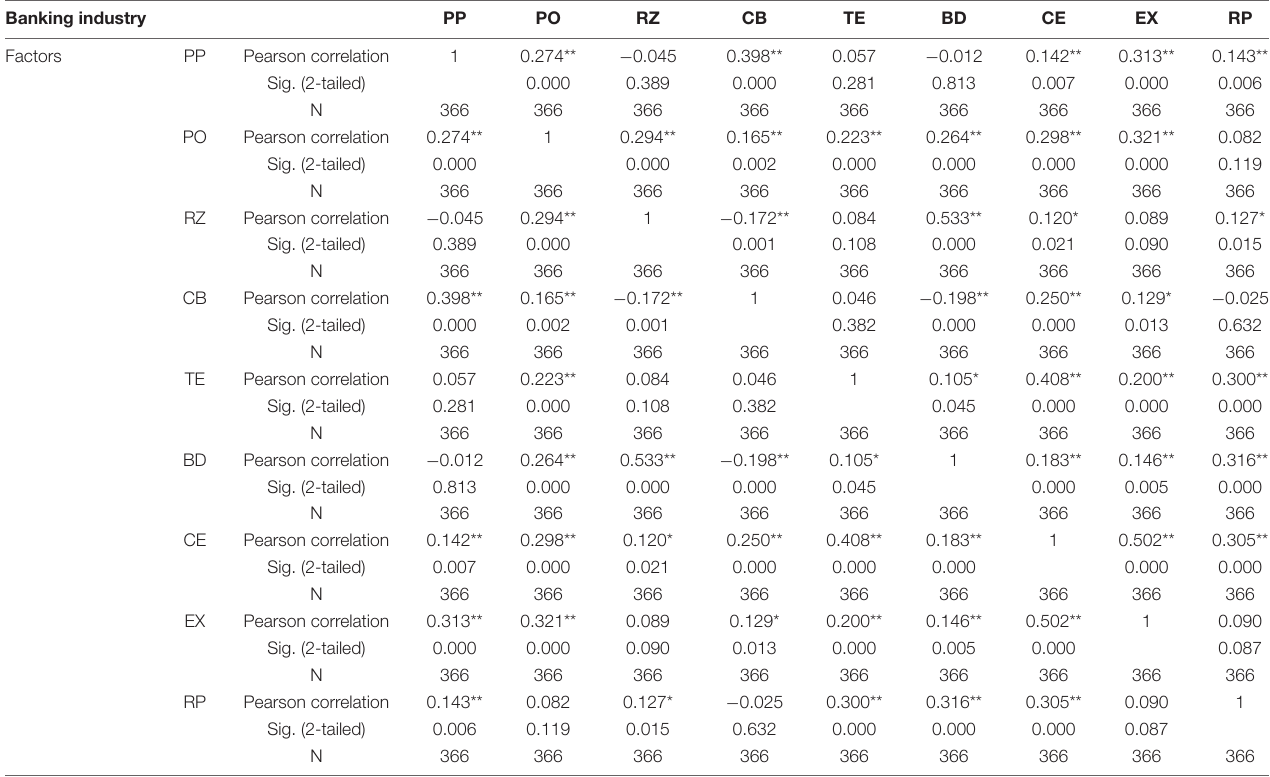
TABLE 3 | Correlation of variables.